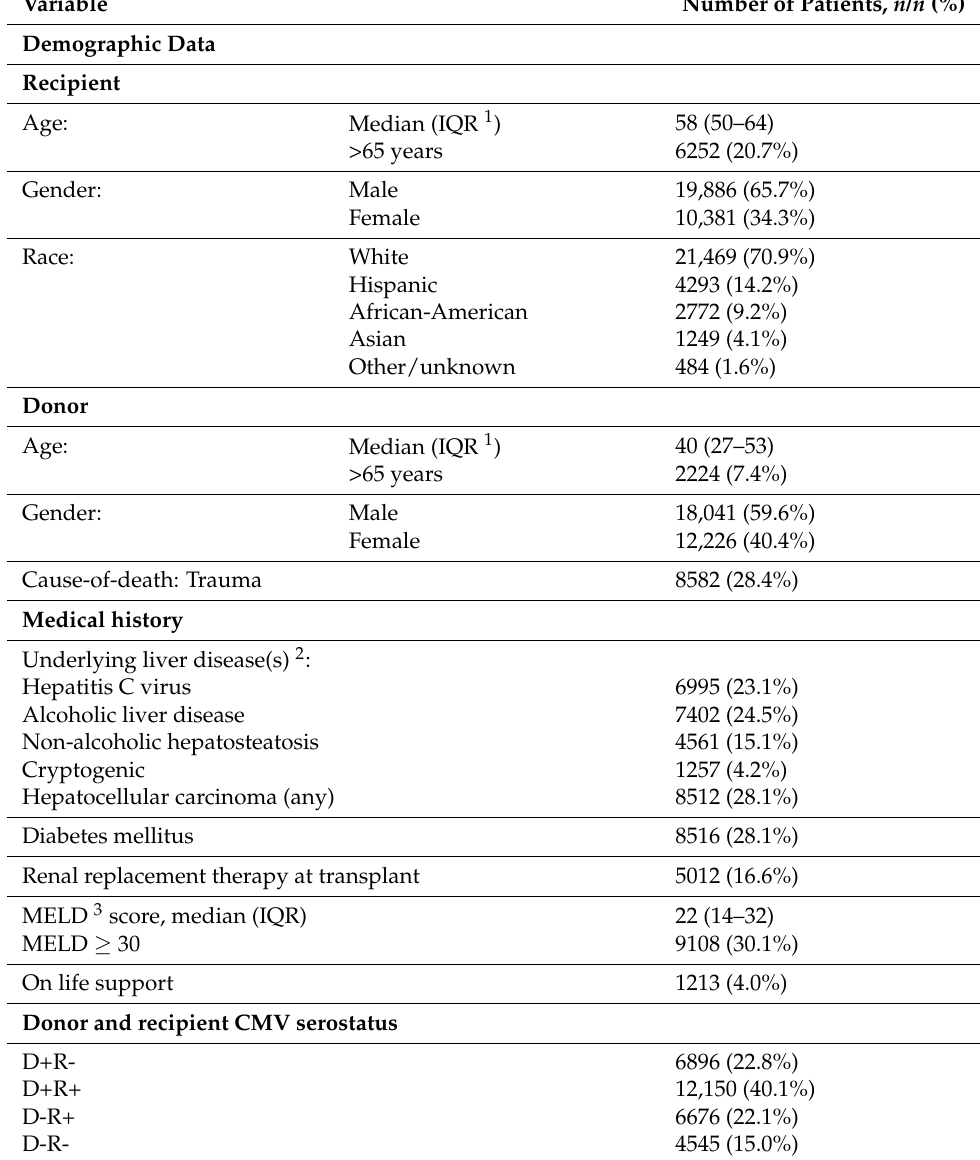
Table 2. Demographic and clinical characteristics of the 30,267 study patients.